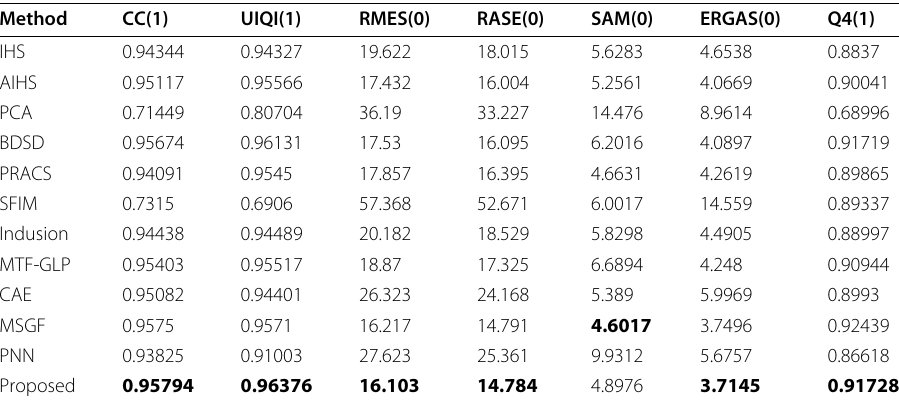
Table 4 Numerical results of the full reference GeoEye-1